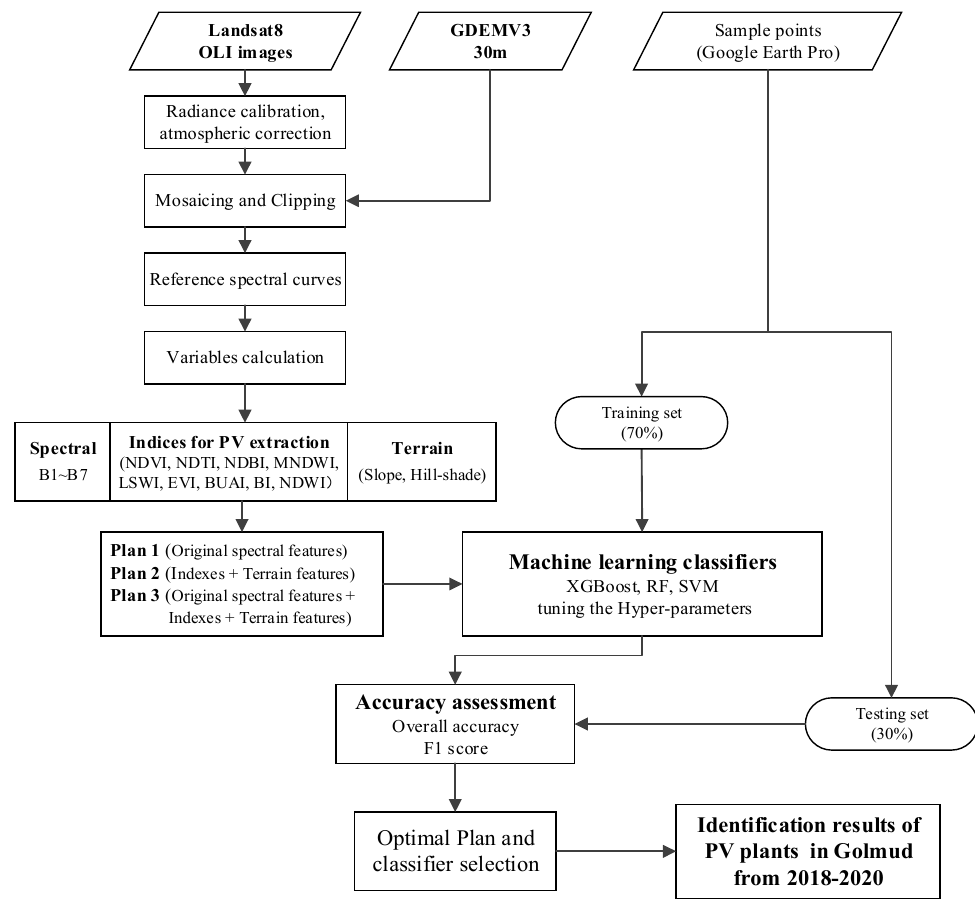
Figure 2. Illustration of the general workflow utilized for the extraction of PV plants in Golmud